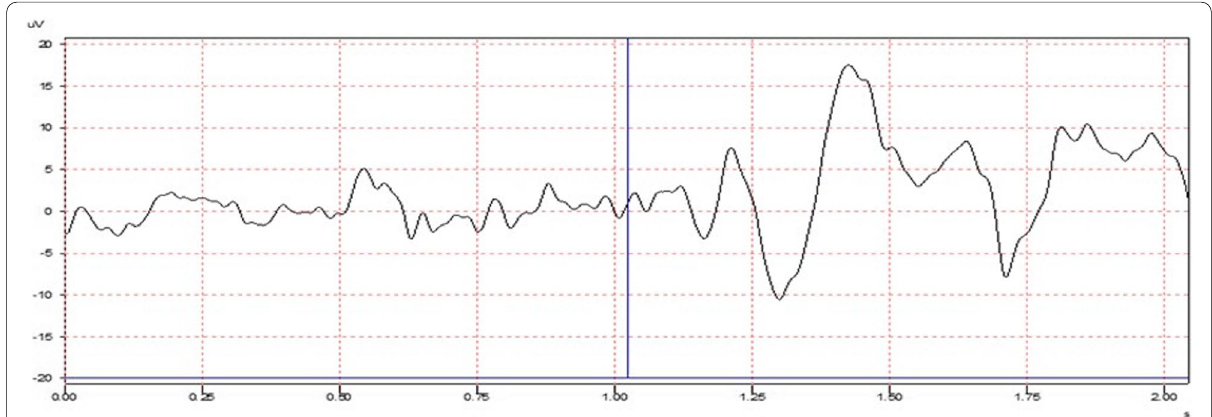
Fig. 1 An illustration of a normal neurophysiological response to a given olfactory